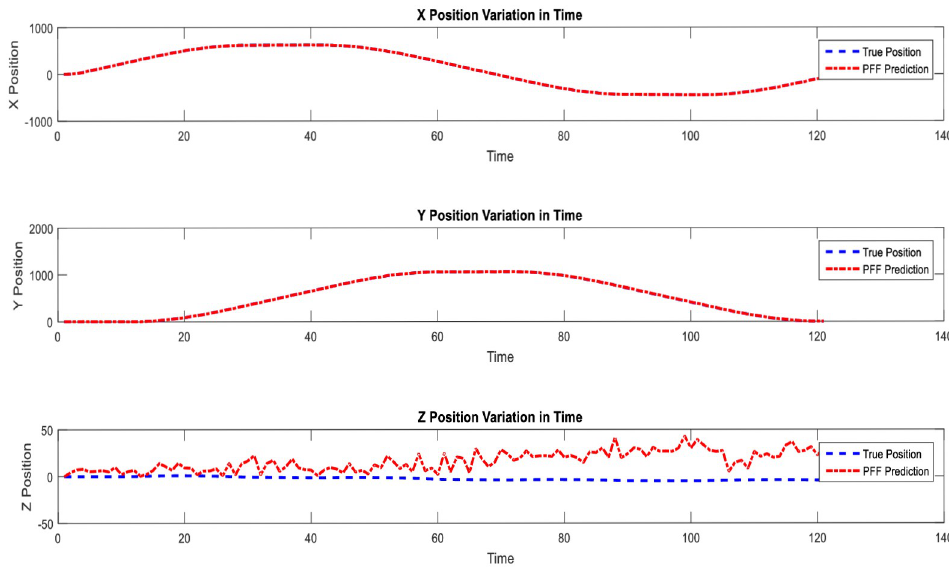
Fig 10. PFF-A-SLAM position